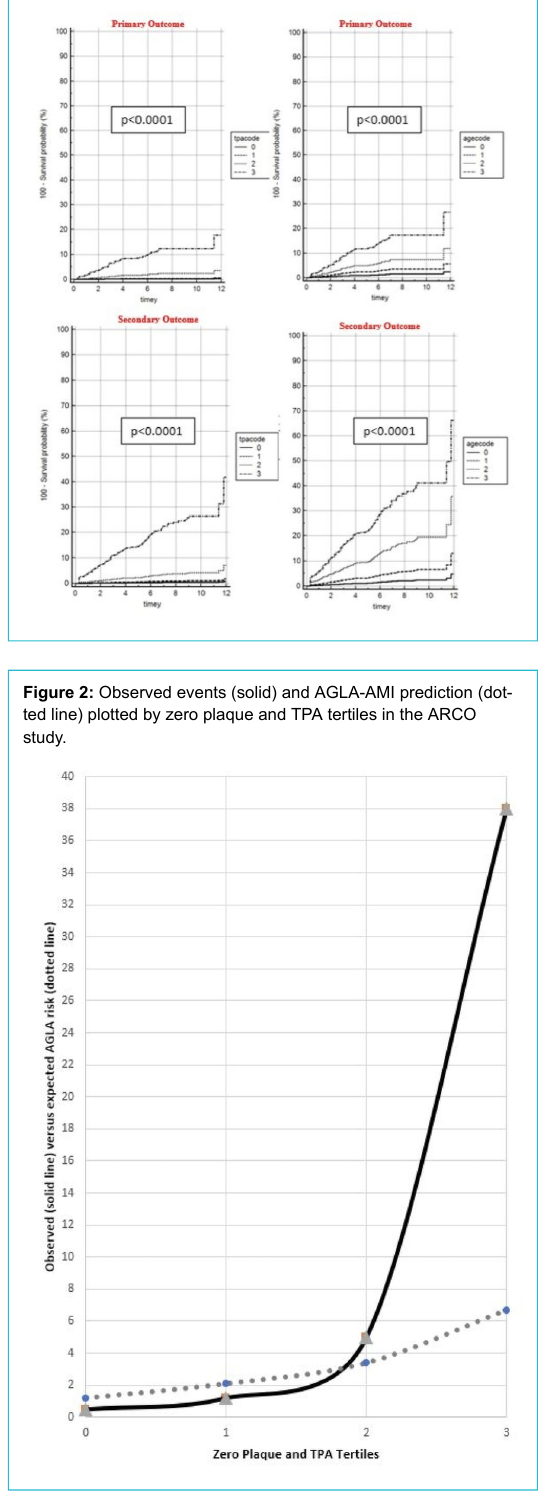
Figure 1: Unadjusted hazard ratioss for primary (hard events) and secondary (all events) outcome associated with TPA and differ- ences in arterial age aacode: arterial age code (0 = below calander age [cAge], 1 = 1–10 years older than cAge, 2 = 11–20 years older than cAge, 3 = >20 years older than cAge). tpacode: total plaque area code (0 = no atherosclerosis, 1 = first tertile, 2 = second ter-